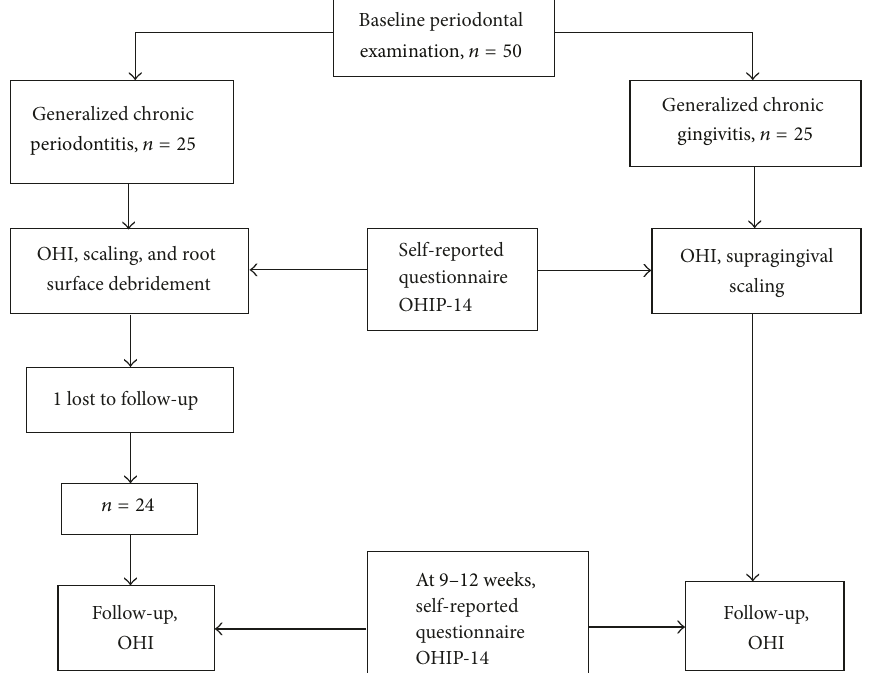
Figure 1: Flow chart of study. OHI: oral hygiene instructions; OHIP-14: Oral Health Impact Profile-14.